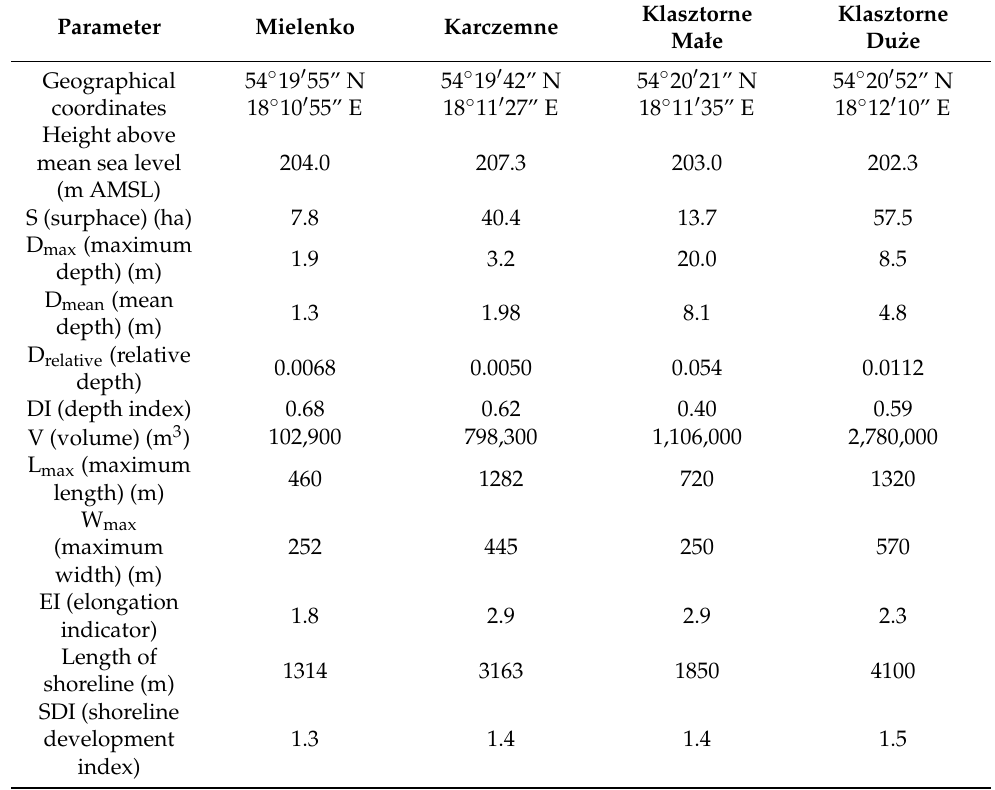
Table 1. Morphometric data of studied lakes